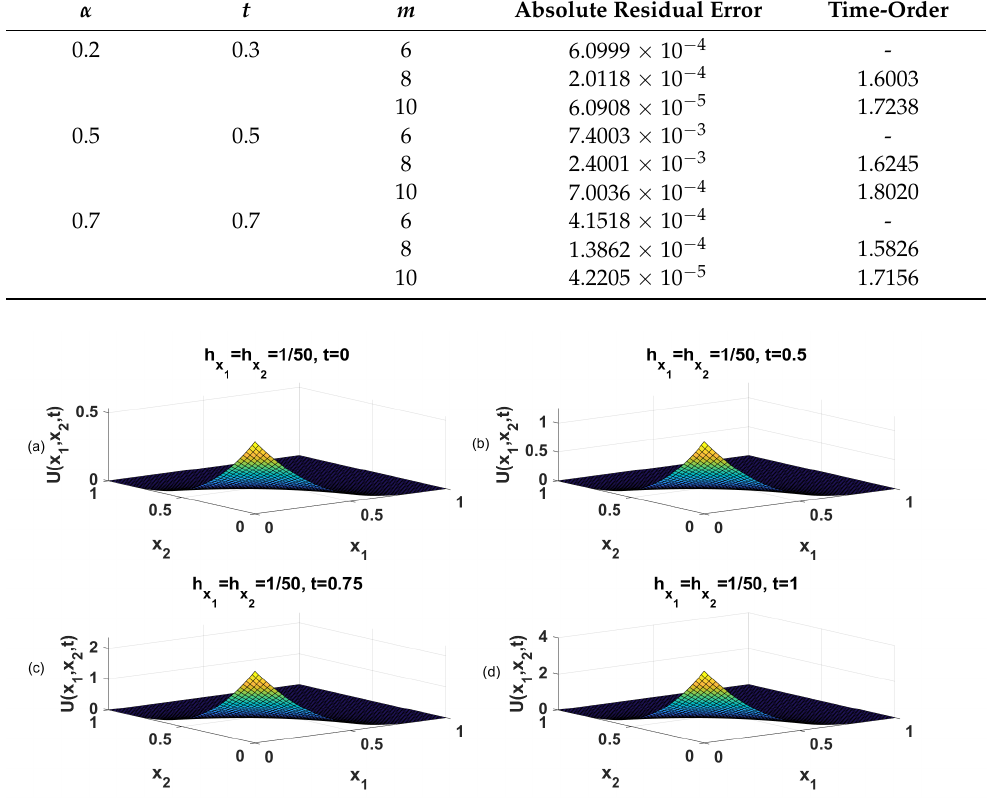
Figure 3. The numerical solutions for Example Section 2.1 for different time values ( a : t = 0, b : t = 0.5, c : t = 0.75, d : t =